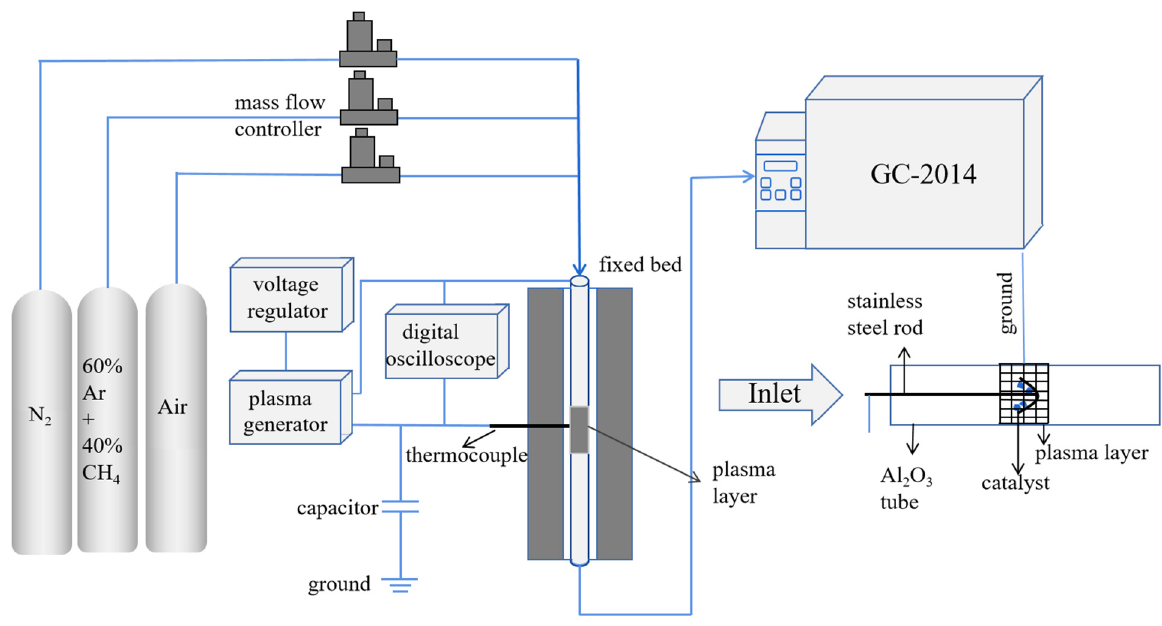
Figure 16. Reaction equipment diagram (the part on the bottom right is a magnification of the catalyst placement).